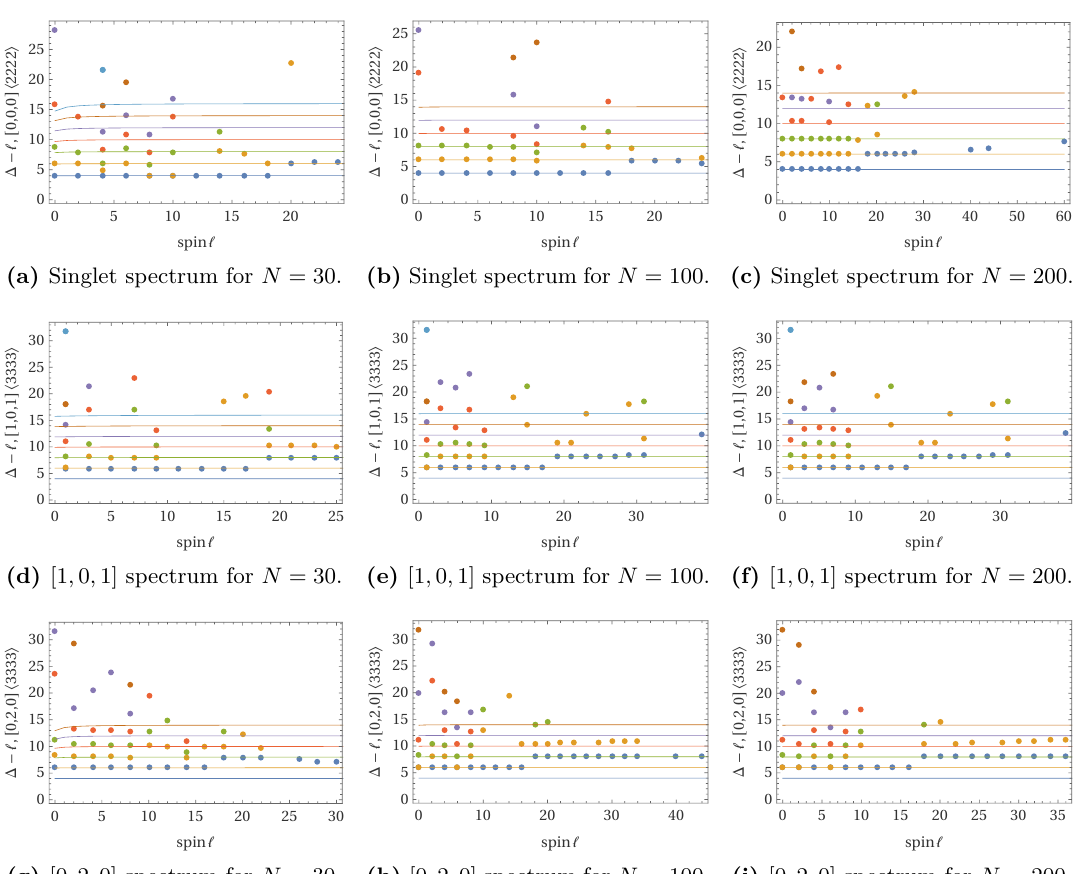
Figure 11. Zeros of the functionals at the boundary of the singlet twist gap exclusion plot. The first one uses only the hO (2) O (2) O (2) O (2) i which sits very close to 4 . Whereas the other two show the representations [1 , 0 , 1] and [0 , 2 , 0] , respectively. They are obtained by bounding the singlet twist gap on hO (3) O (3) O (3) O (3) i which sits very close to 6